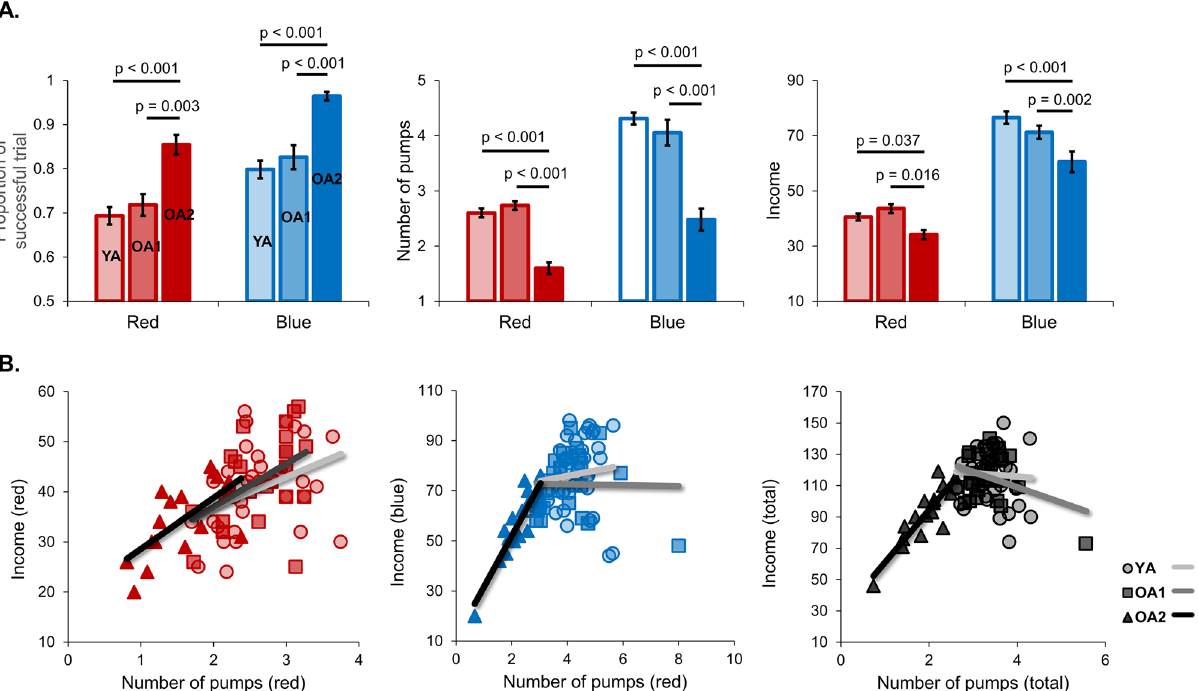
Figure 2. Behavioral performance of the BART. ( A ) Compared with the YA group, the OA1 group showed comparable task performance, including the ratio of successful trials, averaged adjusted number of pumps, and income for red and blue balloons. The OA2 group exhibited significantly poorer performance compared with other two groups (Bonferroni corrected p < 0.05). ( B ) A linear regression analysis was applied to examine the group differences in task performance. The relationship between income and adjusted number of pumps were significantly changed in the OA2 group for the blue and total conditions (middle and right plots), but not for the red condition (left plots). YA, light color; OA1,medium color; OA2, dark color. Region Peak (F value) Cluster (voxels) MNI coordinates Adjusted pumps ( r ) Right SFG